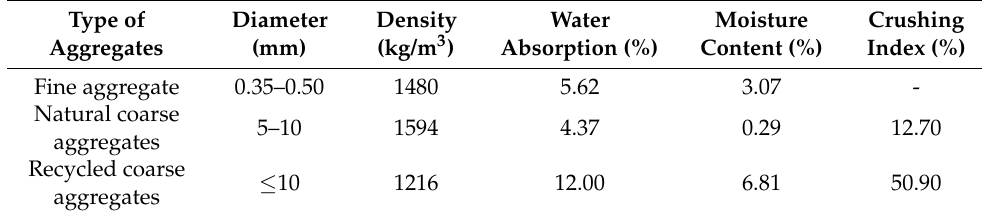
Figure 1. Appearance of constituent materials: ( a ) recycled aggregates with recycled clay brick aggregates, ( b ) sisal fiber and ( c ) jute fabric. Table 1. Physical properties of aggregates used in the tests.